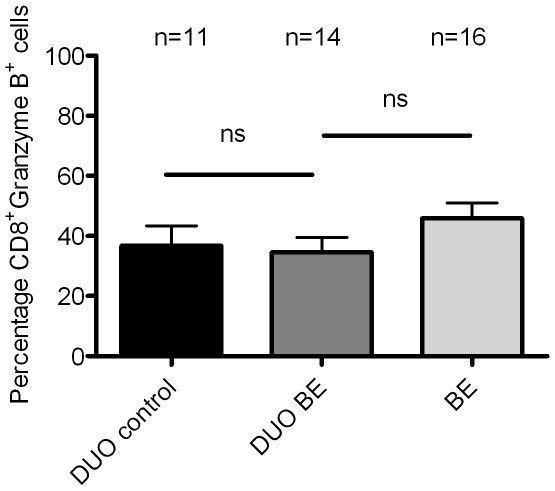
High percentage of CD8+Granzyme Bhigh cells in ex vivo cultures of BE and duodenal tissue.The percentage of Granzyme Bhigh -cells (from CD8+ cells) was measured by an intracellular FACS-staining in ex vivo cultures of 16 BE segments and 14 duodenal tissues from 16 BE patients (DUO BE) and duodenum from 11 controls (DUO controls). Each bar represents mean value±SEM of the percentage CD8+Granzyme Bhigh cells in the CD3+CD8+ population (black bar: DUO control, dark grey bar: DUO BE, light grey bar: BE) (ns not significant).